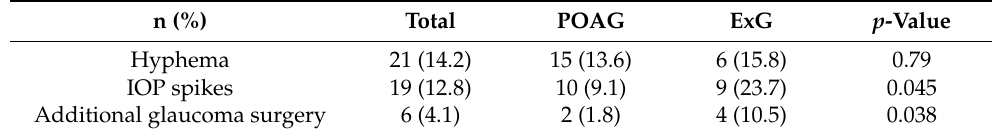
Table 3. Postoperative